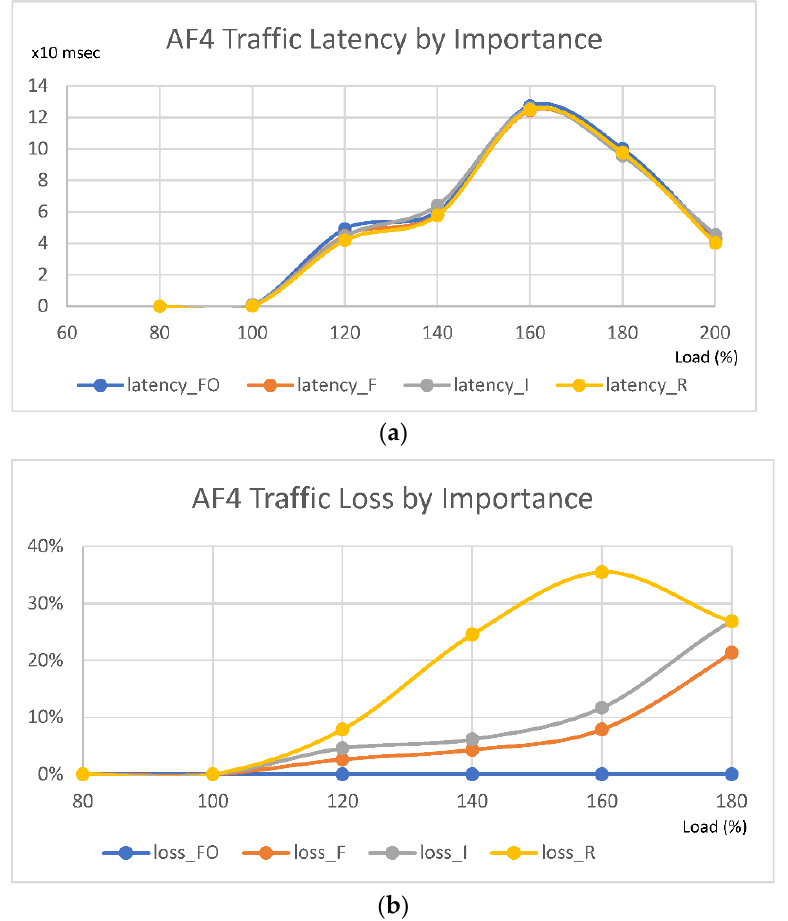
Figure 5. Performance results by importance of the AF4 traffic: ( a ) Latency performance by importance of the AF4 traffic; ( b ) Loss performance by importance of the AF4 traffic.